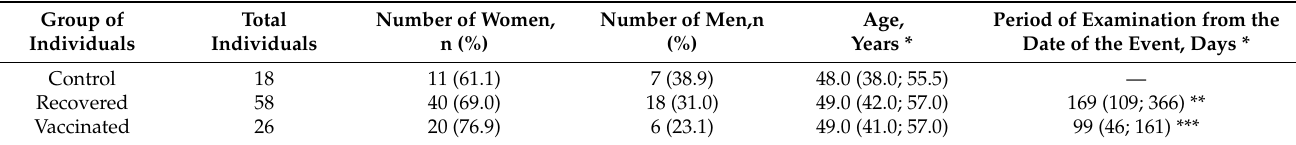
Table 1. Characteristics of the groups.